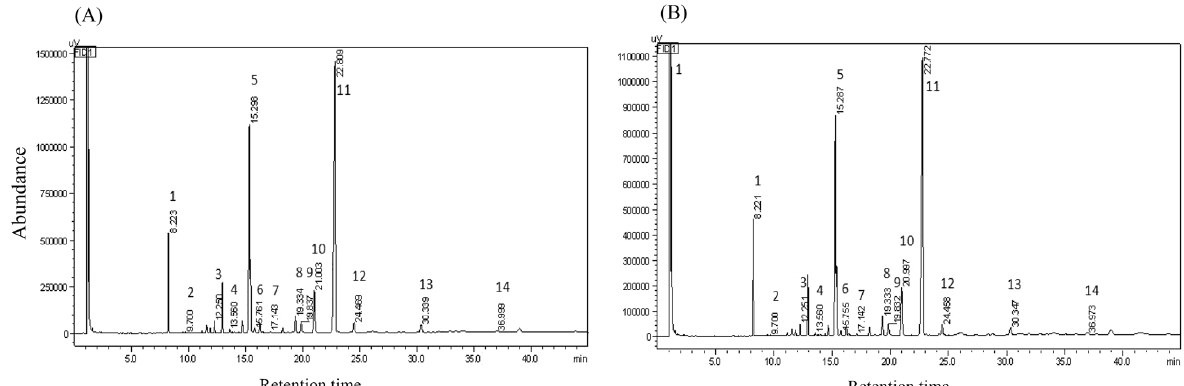
Figure 1. Representative gas chromatograms of the fatty acids in sesame leaves on a DB-5ms column. ( A ) Leaf sample prepared from JQA. ( B ) Leaf sample prepared from JQB. The optical density absorbance is plotted against retention time, and 14 peaks (numbering from 1 to 14) representing different fatty acid compositions were identified by comparing the retention time with that of standard fatty acid compounds. The absolute content (mg/g) for each fatty acid can be inferred from a linear regression established by plotting the injected amount of each fatty acid standard against the obtained peak area of the derivatives. Peak identity was as the following. 1: Undecylic acid (C11:0); 2: Lauric acid (C12:0); 3: Myristic acid (C14:0); 4: Pentadecane acid (C15:0); 5: Palmitic acid (C16:0); 6: Palmitate acid (C16:1); 7: Heptadecanoic acid (C17:0); 8: Stearic acid (C18:0); 9: Oleic acid (C18:1); 10: Linoleic acid (C18:2); 11: Linolenic acid (C18:3); 12: Arachidic acid (C20:0); 13: Elm acid (C22:0); 14: Paraffinic acid